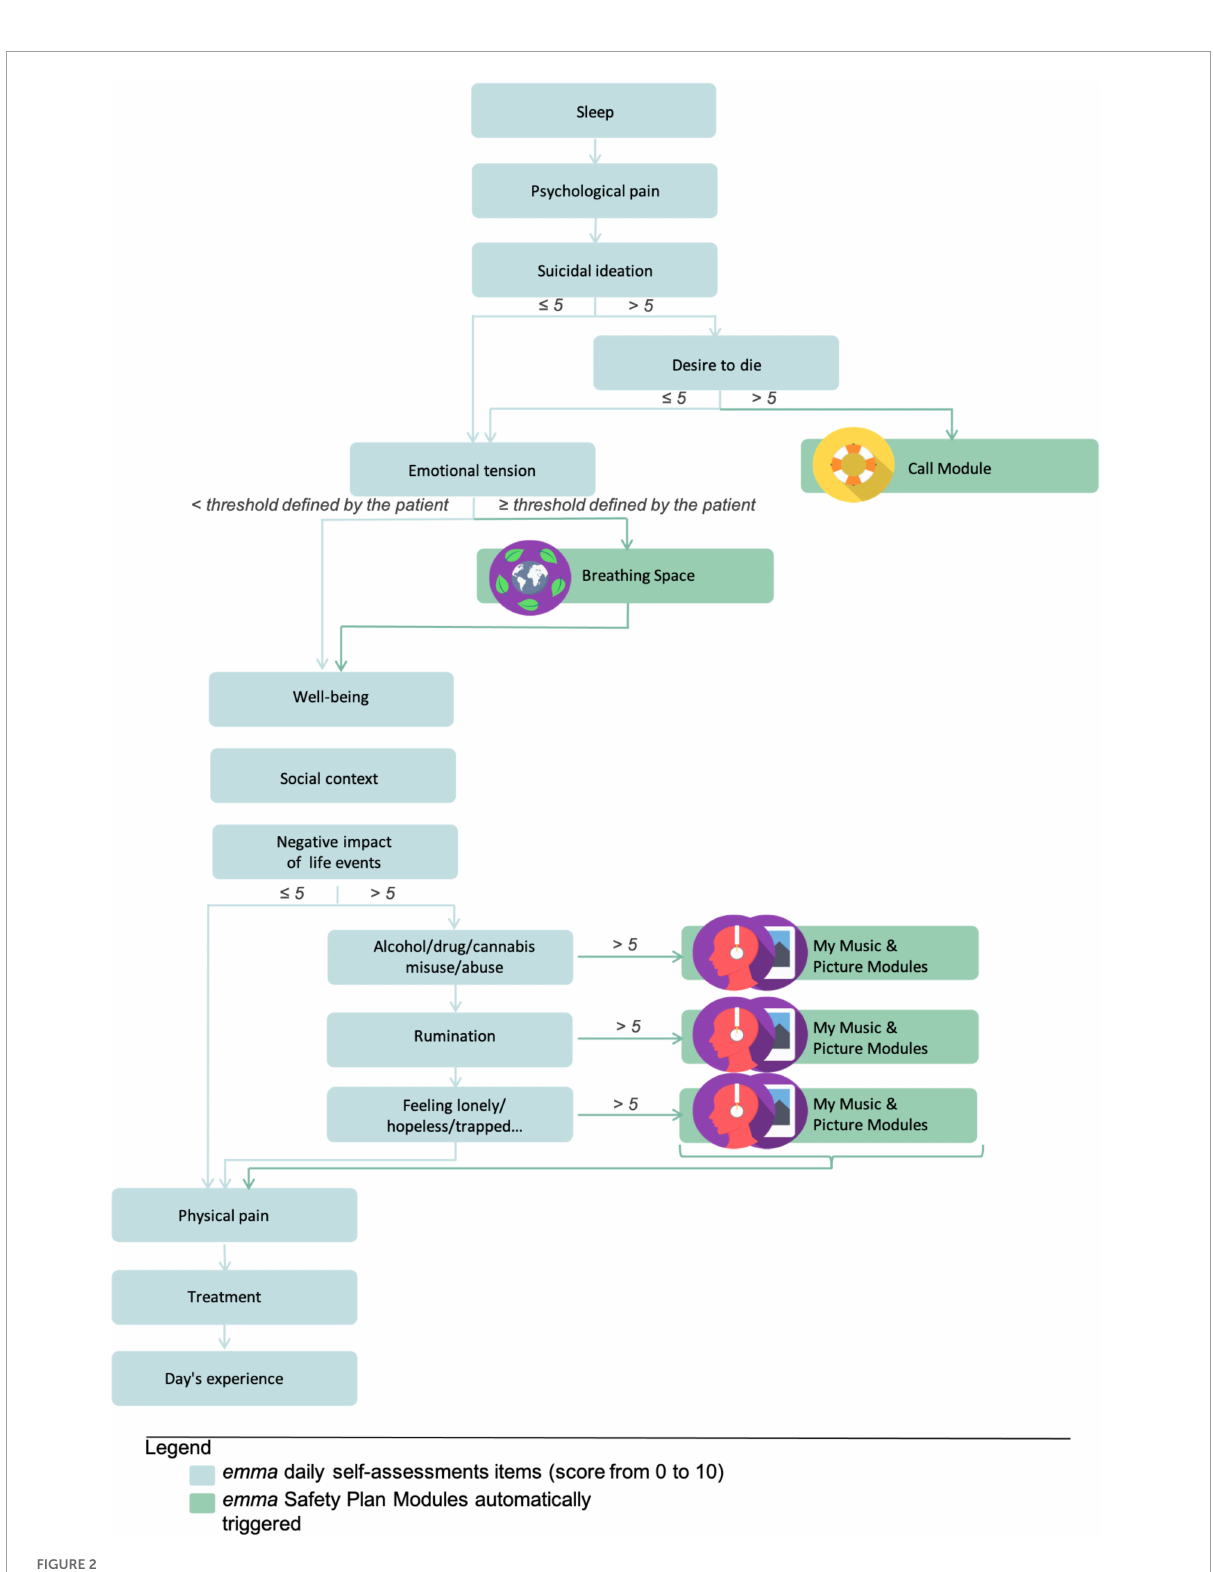
FIGURE2 Algorithm for automatic ecological momentary intervention (EMI) triggering according to the ecological momentary assessment (EMA) answer thresholds.